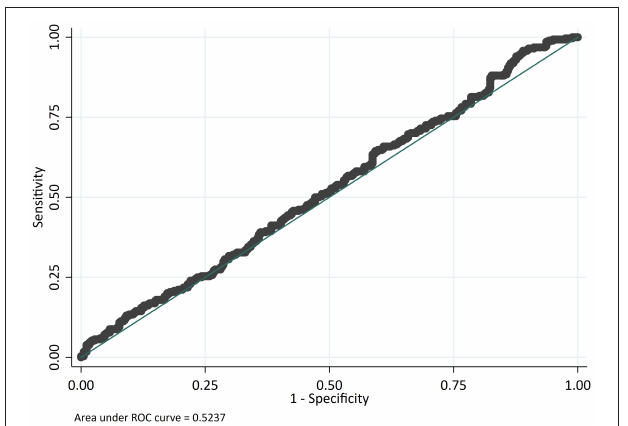
FIGURE 5 | Receiver operating characteristic (ROC) curve and Logistic regression for Pediatric Logistic Organ Dysfunction (PELOD) predicting mortality.